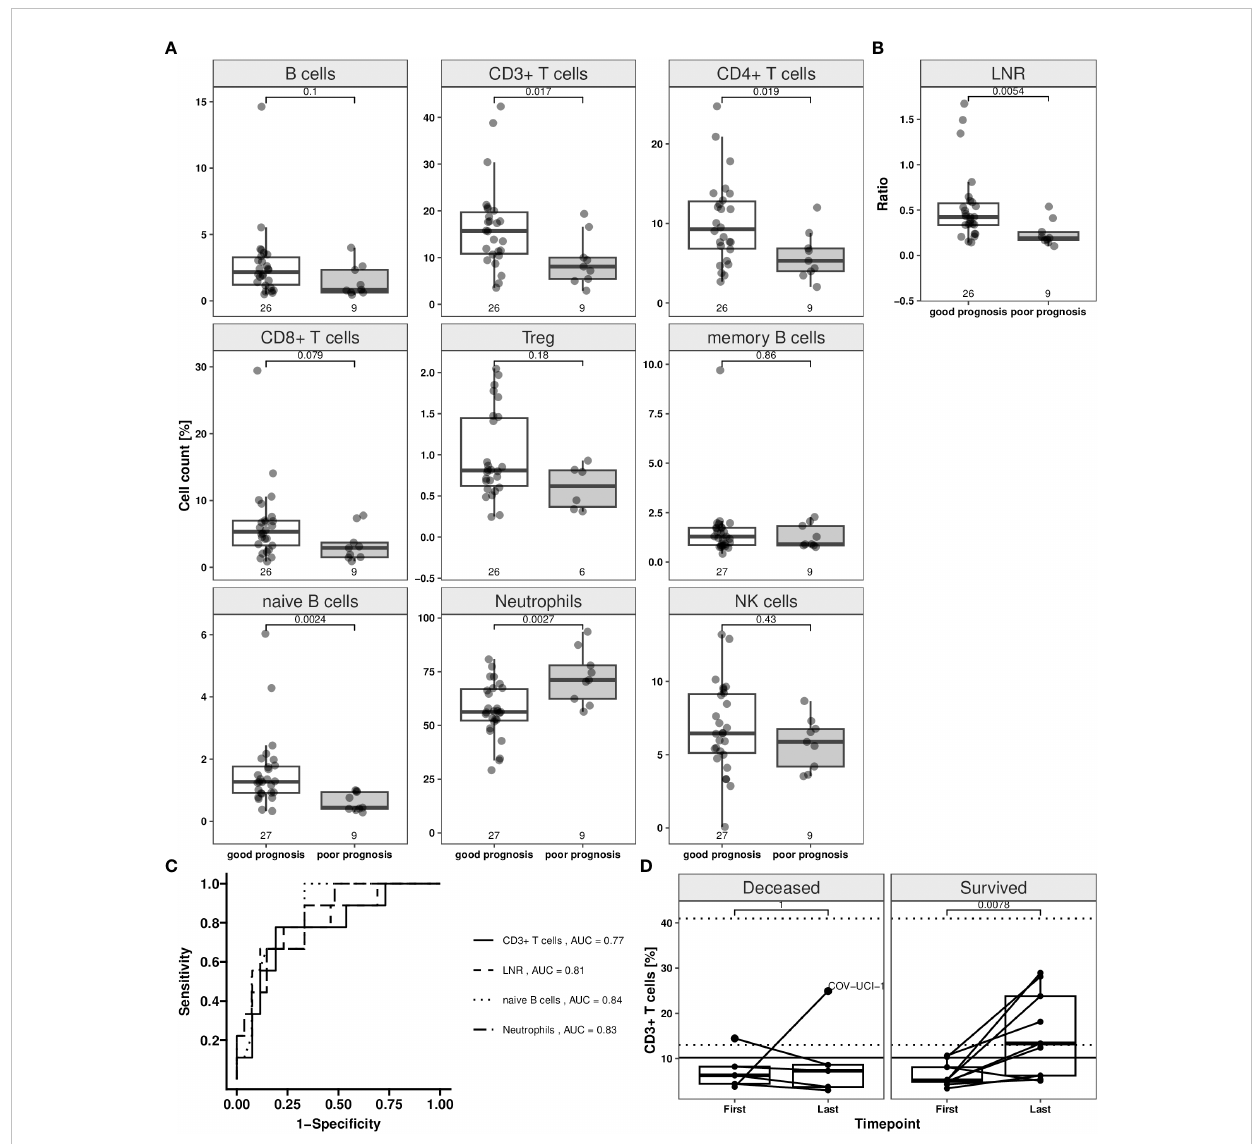
FIGURE 3 Immune cell counts depending on disease status switch in COVID-19 patients in whole blood samples. The disease status was assessed in accordance with RKI classi fi cation of hospitalized COVID-19 patients. The “ good prognosis ” group consists of patients (n = 27) which showed an improvement until second available time point compared to fi rst time point. Improvement was assumed when a change from severe to moderate and persistent moderate grade was found. Patients with a change from moderate or severe to critical, moderate to severe grade were classi fi ed as “ poor prognosis ” group (n = 9). Patients were represented in both groups, when showing status change from second to third time point. Epigenetic data for the fi rst and second time point (when status changed from second to third time point) are illustrated in the plots (white box: good prognosis; grey box: poor prognosis). Jittered scatter indicates actual cell count for a single sample. (A) Boxplots for T and B lymphocyte subpopulations (CD19 + B, CD3 + , CD4 + , CD8 + , regulatory T (Treg), memory, naïve B cells), neutrophils and CD56dim natural killer [NK] cells. (B) Boxplot for lymphocyte-to-neutrophil ratio (LNR). (C) Prognostic performance for the markers CD3 + T cells, LNR, naïve B cells and neutrophils for a good prognosis was assessed by “ receiver operating characteristic ” (ROC) analysis, encoding good prognosis as 0 and poor prognosis as 1. Calculated area under the curve (AUC) for the four markers are shown in the plot. (D) CD3 + T cell course of Valencia cohort from fi rst and last time point. Dynamic changes of CD3 + T lymphocytes in COVID-19 patients admitted into hospital. Relative numbers of CD3 + T lymphocytes are analysed at fi rst and last available time point after hospital admission. Only patients with more than two time points were included in this analysis. Solid horizontal line shows the CD3 + T cell threshold of ≥ 10.2% that marks the count that was de fi ned as recovery limit. Each patient trajectory is illustrated by a line between two time points (deceased: n = 5, survived: n = 9). Dotted horizontal lines mark the normal “ healthy ” CD3 + T cell range (95% CI: 12.99 – 40.97%). One patient (labelled with “ COV-UCI-1 ” ) was not following the pattern. Boxes display the interquartile range. Whiskers extend maximally 1.5 times the interquartile range from the upper/lower end of the box. Observations farther than that are considered outliers. All p values relate to the Wilcoxon rank sum test for median differences and are displayed above the respective